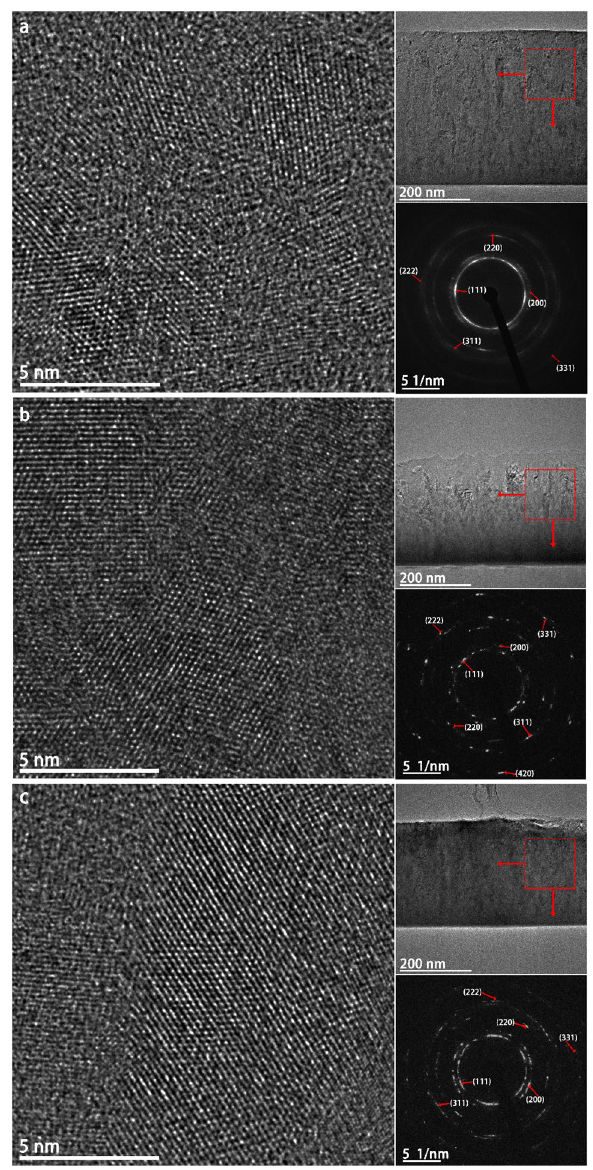
shown in the BF TEM images with low